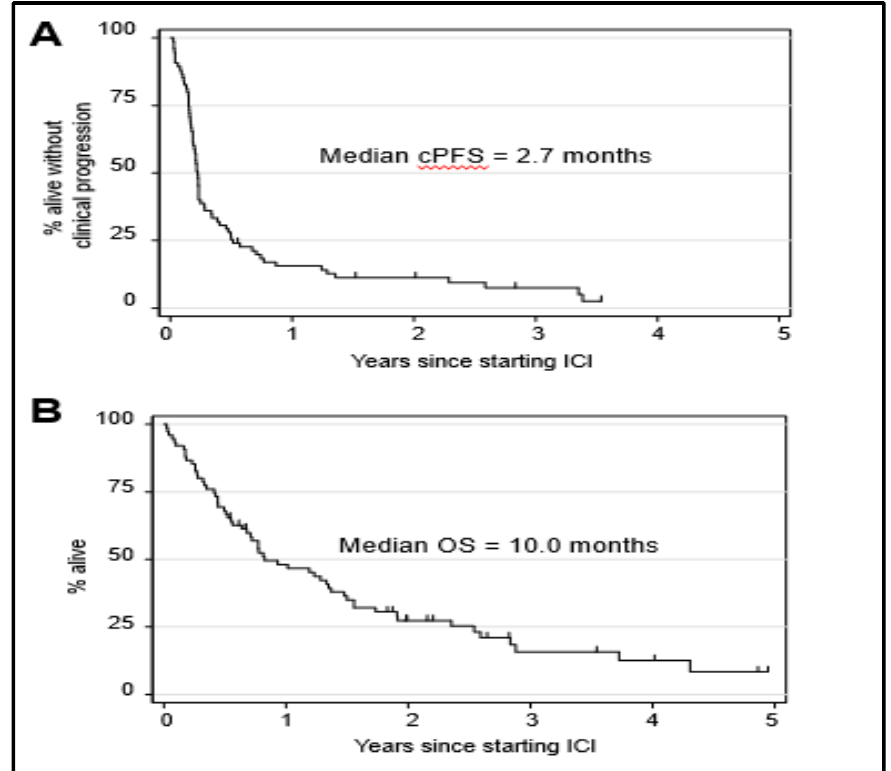
Figure 1. Survival of metastatic uveal melanoma (mUM) patients who received anti-PD1± anti- CTLA4 ICI. ( A ) Clinical progression-free survival and ( B ) overall survival of the entire cohort of 75 mUM patients. Tick marks indicate censored patients.